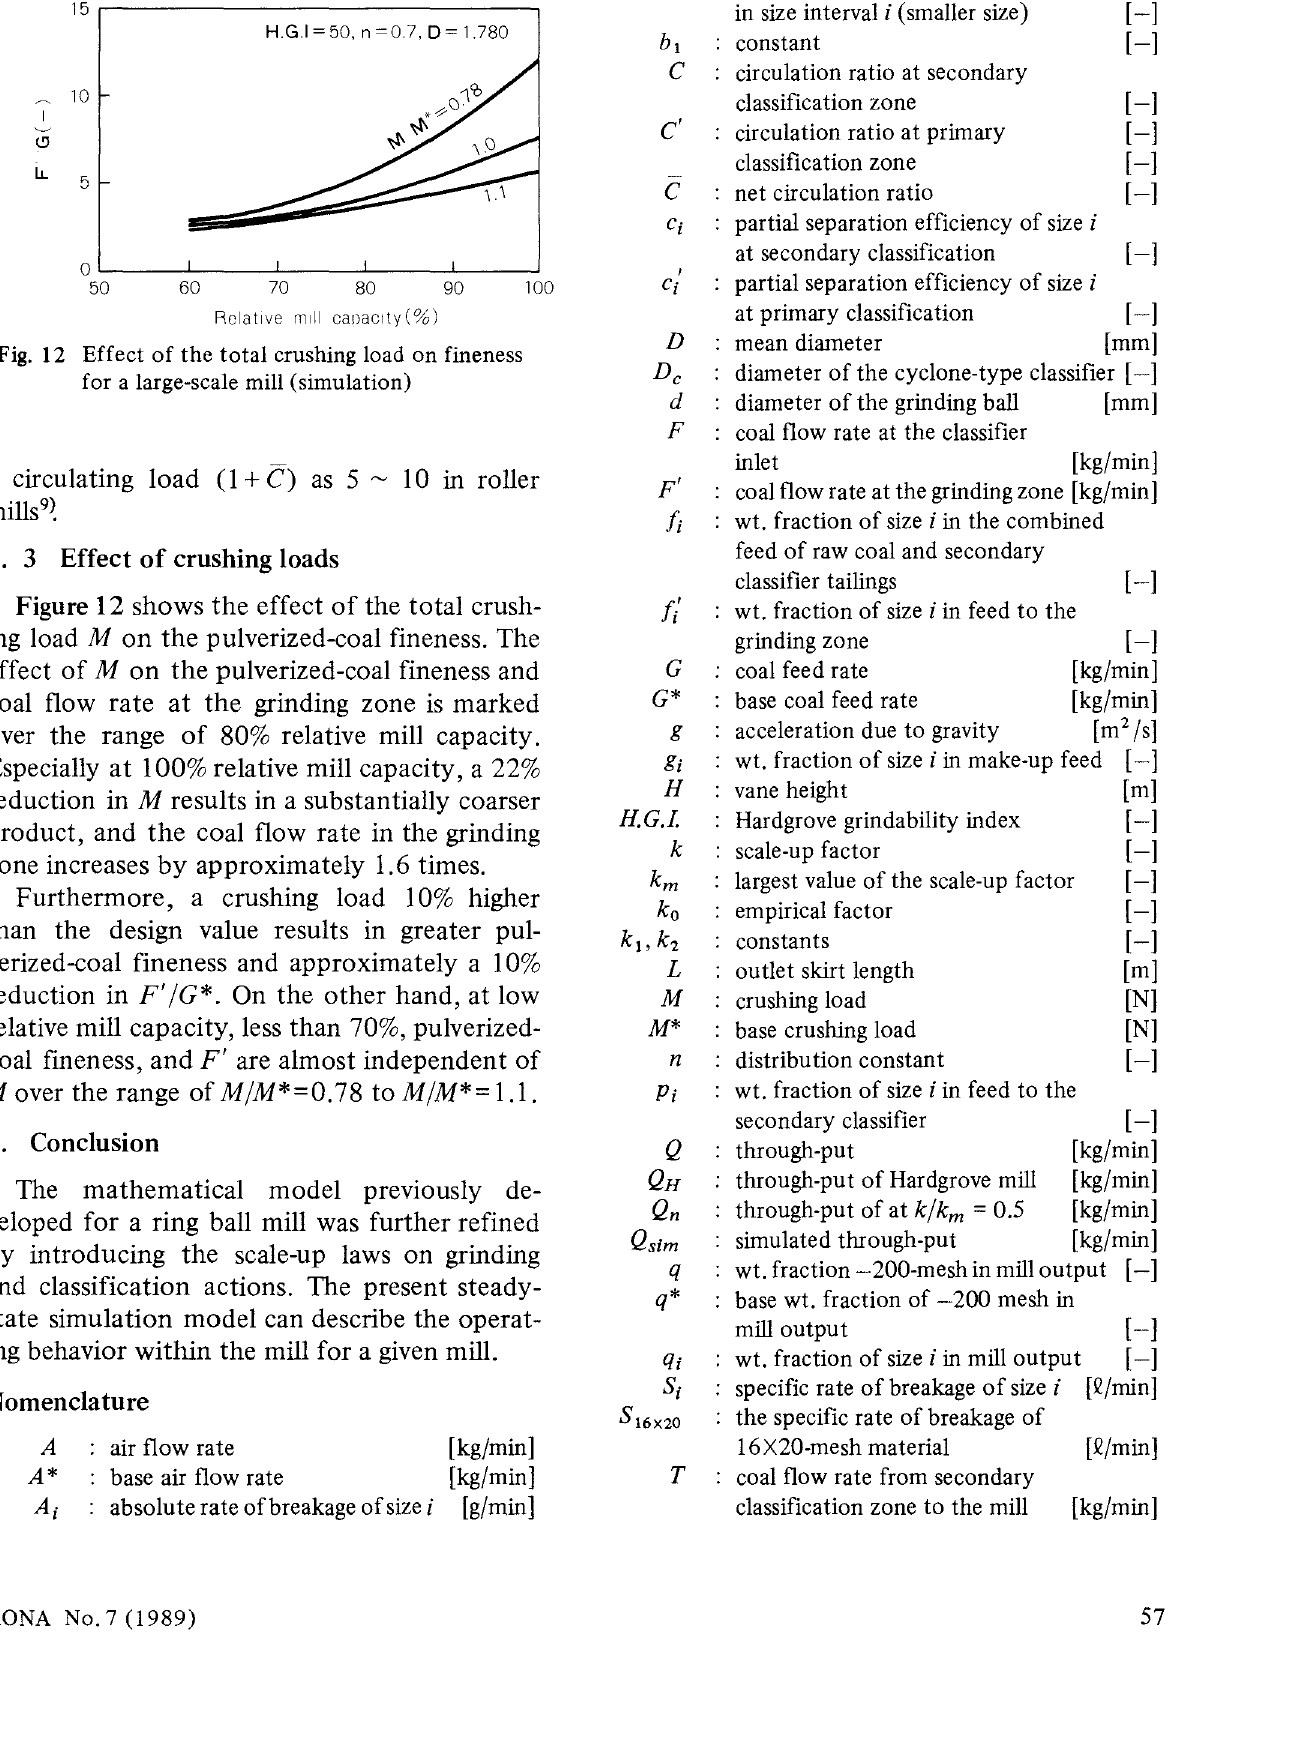
Fig. 12 Effect of the total crushing load on fineness for a large-scale mill (simulation)